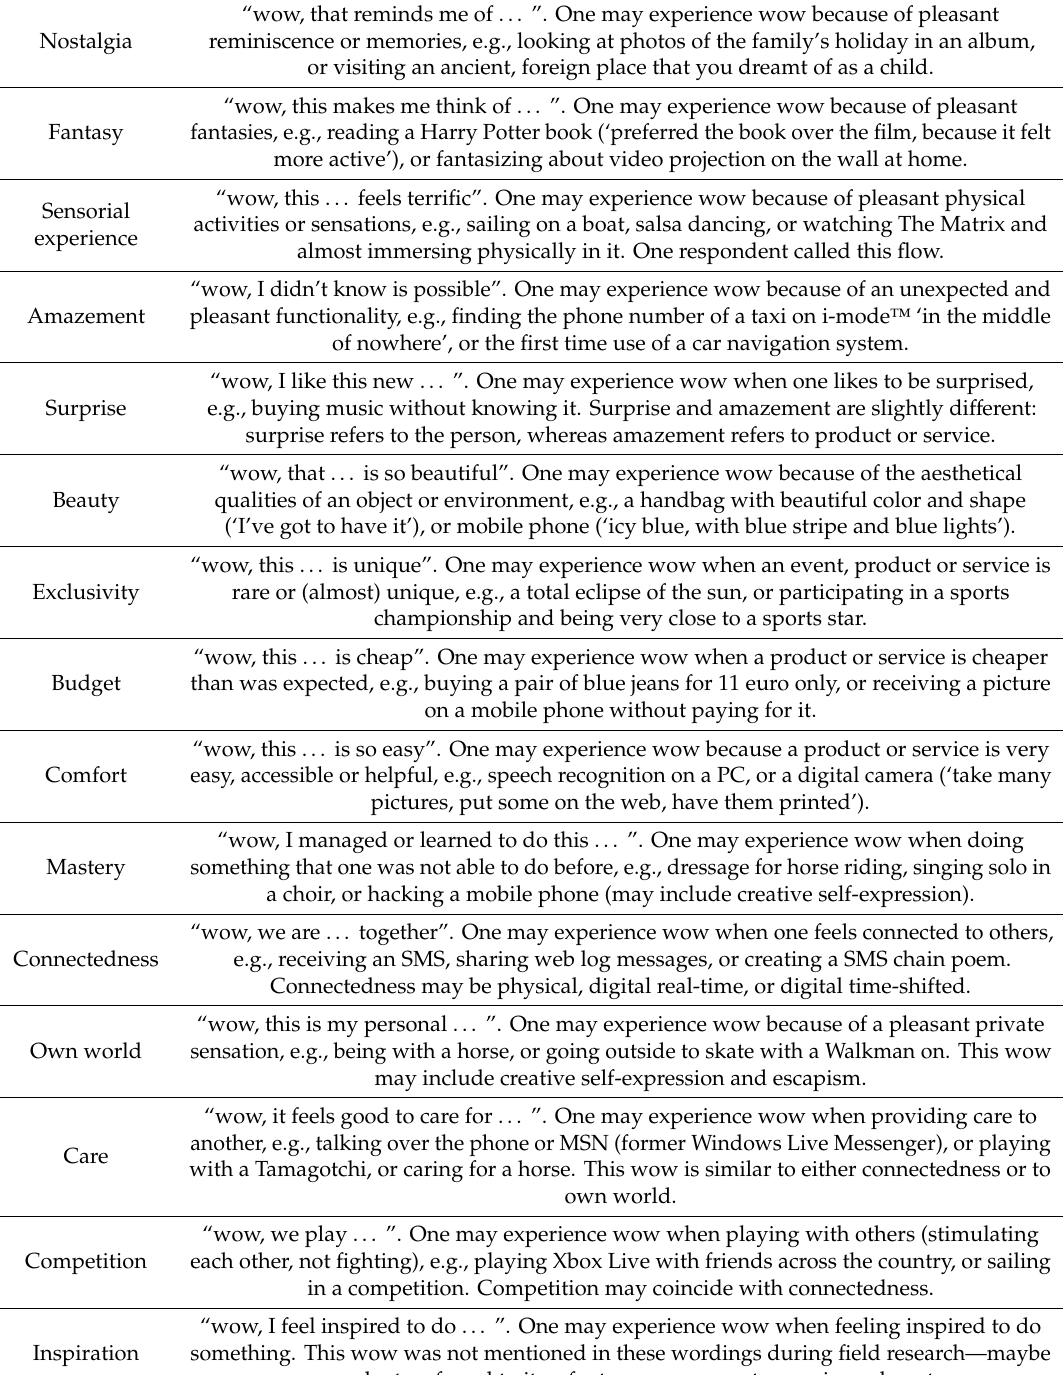
Table 1. Wow factors and examples [2] (p.